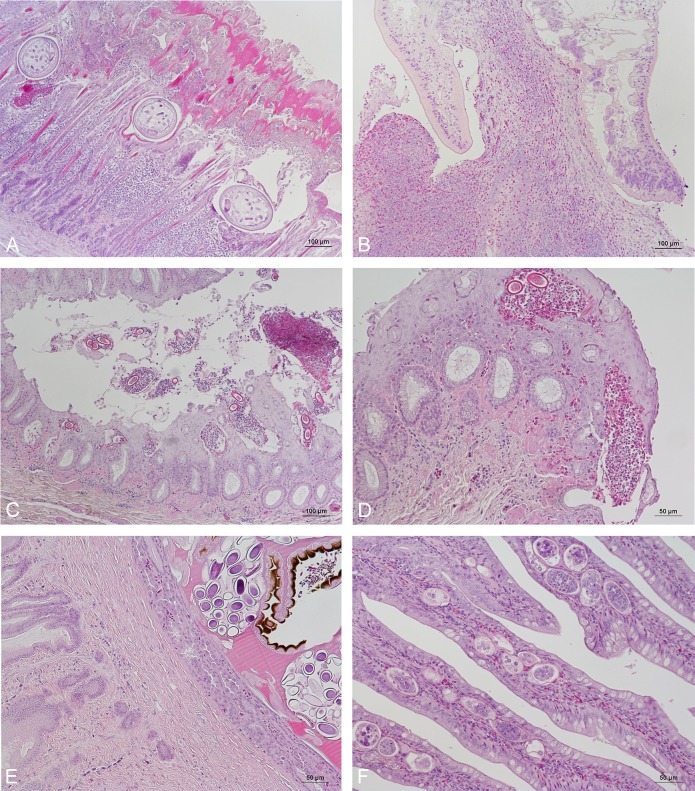
Microscopic parasite findings in Herring gulls (Larus argentatus).(A) Nematode infection in the gizzard with disruption of the koilin layer, focal necroses and lymphoplasmacytic inflammation (bird no. 12, S1 Table). H&E, bar 100 μm. (B) Trematodiasis (Ichtyocotylarus platycephalus (Creplin, 1825) of the bursa of Fabricius. Lymphocyte and heterophilic granulocyte infiltration and effacement of lymphoid follicles can be observed adjacent to rostral parasite structures (bird no. 6, S1 Table). H&E, bar 100 μm. (C–D) Oesophageal mucosa infected by Capillaria sp. Parasite eggs are present in the mucosa and in the lumen in association with inflammatory cells and necrotic debris (bird no. 11, S2 Table). H&E, bar 100 μm (C), 50 μm (D). (E) Proventricular mucosa with a trematode present in a submucosal gland. Note compression of glandular epithelium and absence of an inflammatory reaction (bird no. 6, S2 Table). H&E, bar 50 μm. (F) Jejunal villi with large numbers of parasite larvae (bird no. 17, S2 Table). H&E, bar 50 μm.